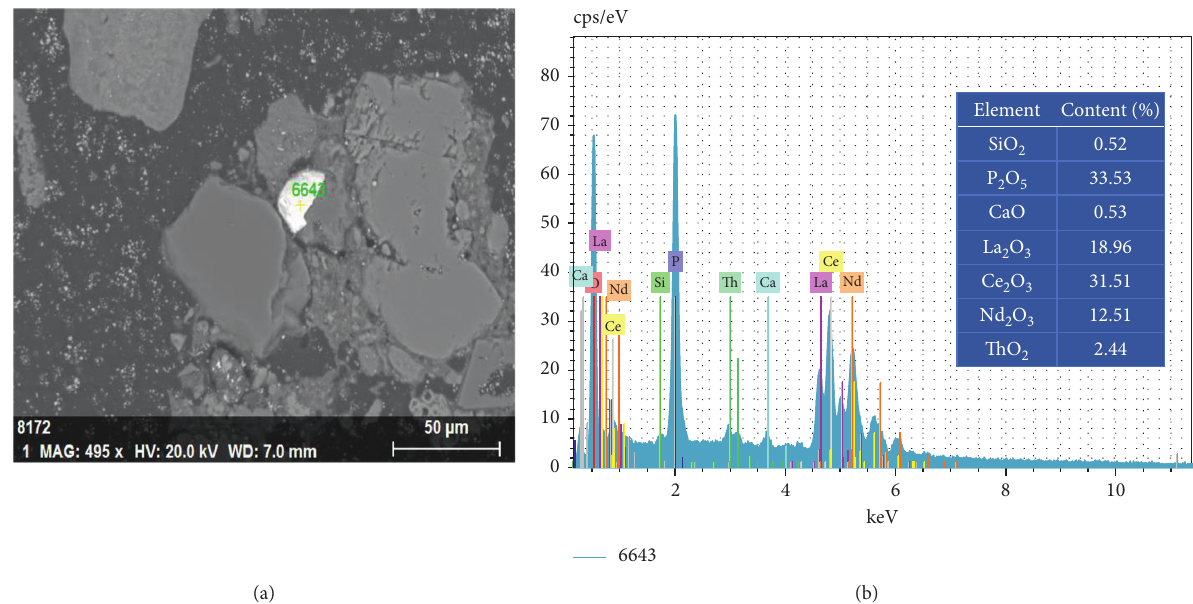
Figure 7: Backscattered electron diagram and energy spectrum analysis of monazite.